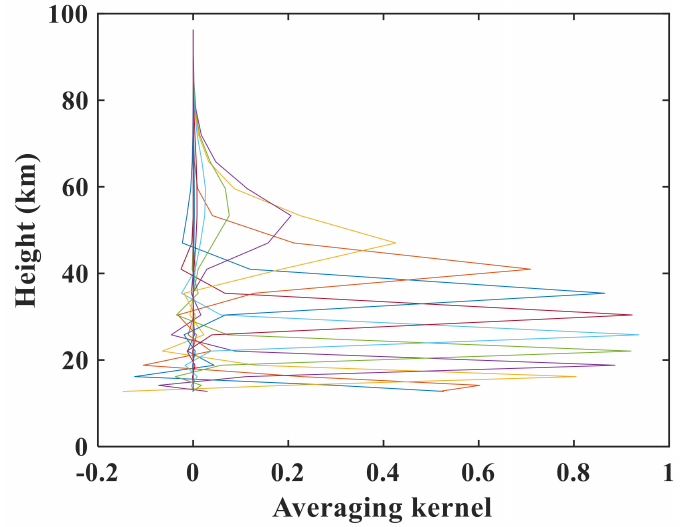
Figure 14. NO 2 averaging kernel for